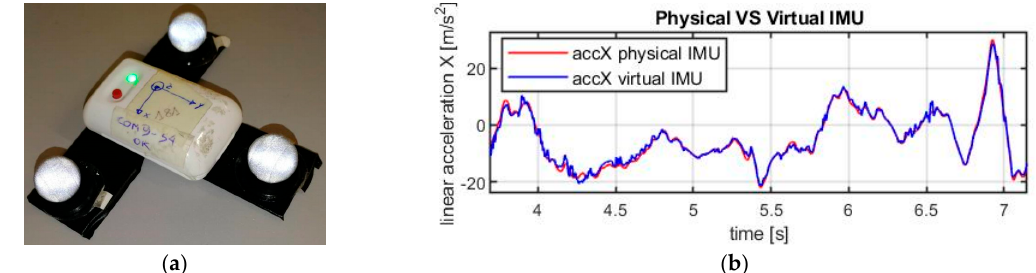
Figure 2. Assessment of the validity of the virtual IMU (inertial measurement unit) method. ( a ) Triad of reflective markers placed corresponding to the axes of the IMU (in white); ( b ) Example of comparison of data of linear acceleration coming from the physical (red) and virtual (blue) IMU